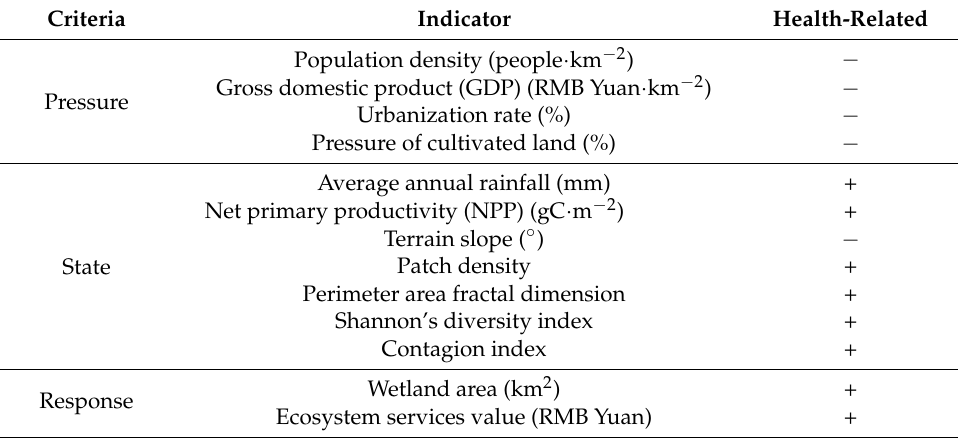
Table 1. Indicators of wetland ecosystem health in the Yangtze and Amazon River